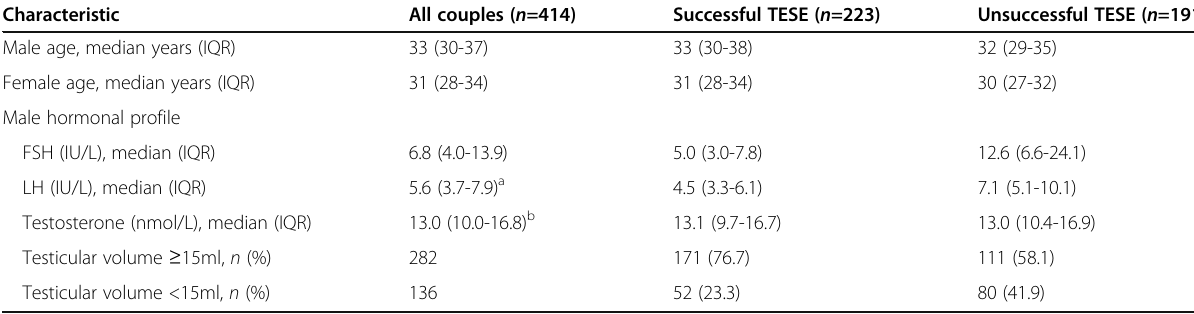
Table 1 All cohort demographics for those couples with successful and unsuccessful TESE